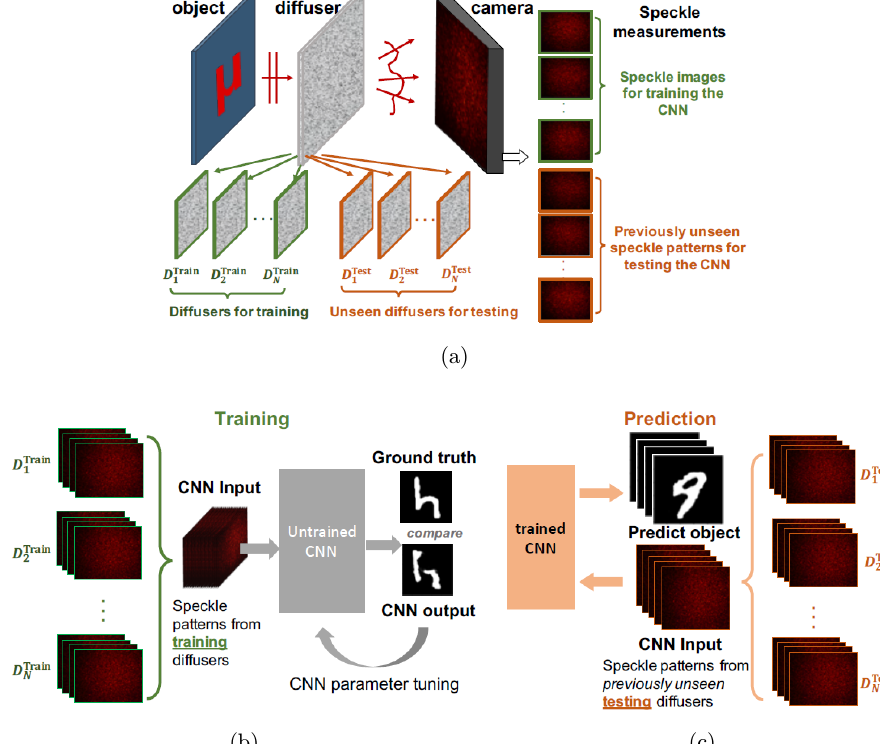
Fig. 3. Diagram of deep learning-based scalable imaging through scattering media. (a) Speckle measurements are repeated on multiple di®users, (b) During the training stage, only speckle patterns collected through the training di®users D train D train are used and (c) During the testing stage, objects are predicted from speckle patterns collected through previously unseen N ; D test ; ... ; D test testing di®users D test , demonstrating the superior scalability of this deep learning-based approach. Reproduced 1 2 N from Ref.